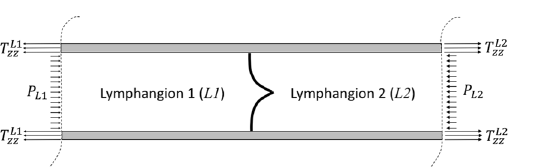
Figure 7. Illustrative schematic of two adjacent lymphangions, separated by a one-way valve. The trans-valvular pressure (e.g., − P P ) will lead to differences in the Cauchy stress in the wall. Differences in the axial L L 2 1 component of the Cauchy stress requires differences (e.g., − T T ) zzL zzL 2 1 necessitate differences in the axial stretches ( λ zL 1 versus zL 2 λ ). This simple mechanical analysis suggests that axial stretch in a lymphangion will change over the pumping cycle, as valves open and close and lymphangions contract differentially in